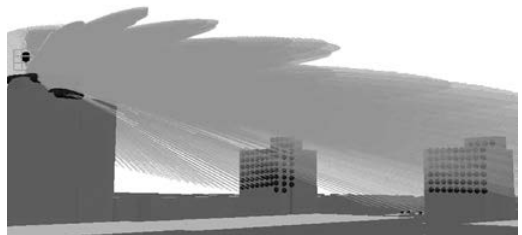
Fig. 3. Intersection points of rays and building